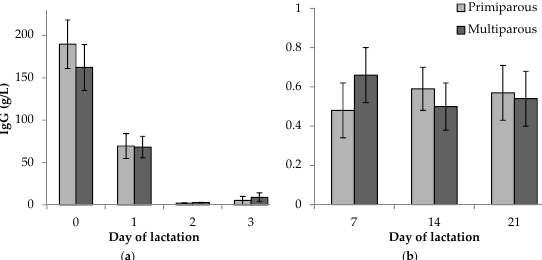
Figure 1. Comparison of total IgG concentration (g/L) between primiparous and multiparous sows in: ( a ) colostrum and transient milk (days 0 to 3); and ( b ) milk in later stages of lactation (days 7 to 21). Error bars represent the standard error of the mean (± SEM).